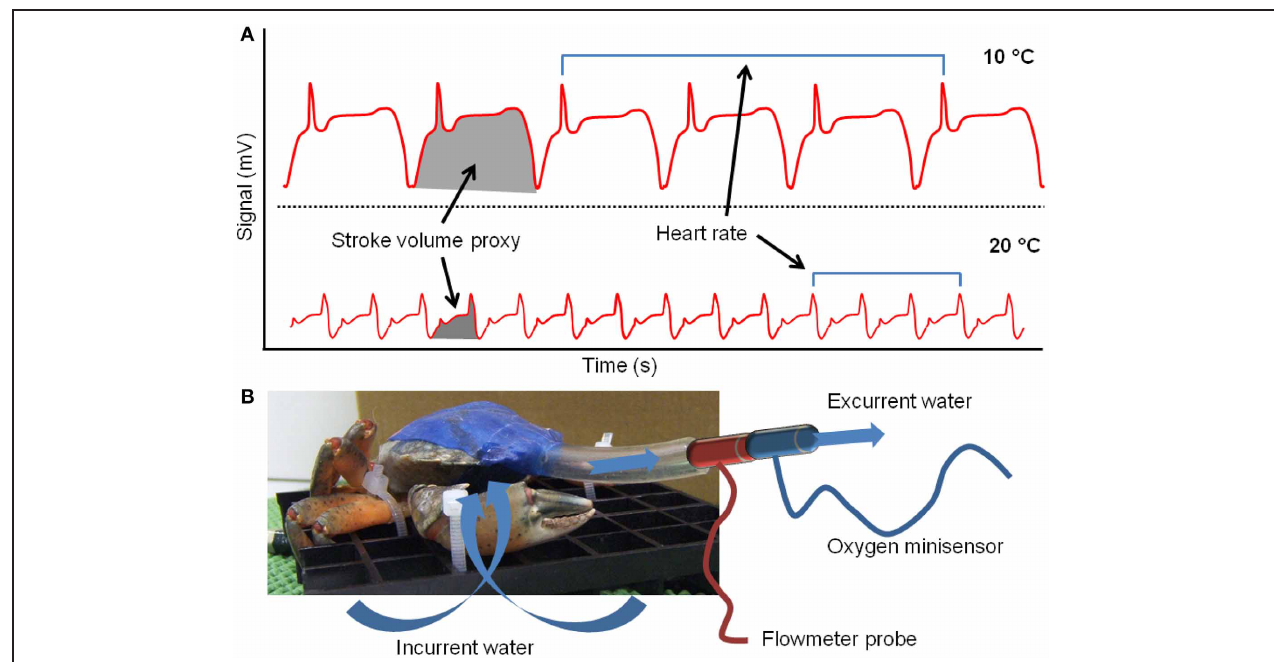
from the frequency of the signal (blue bars). (B) Schematic of the “rubber mask” device used to simultaneously measure ventilation effort and oxygen consumption rate (shown on a crab temporarily emersed from its water